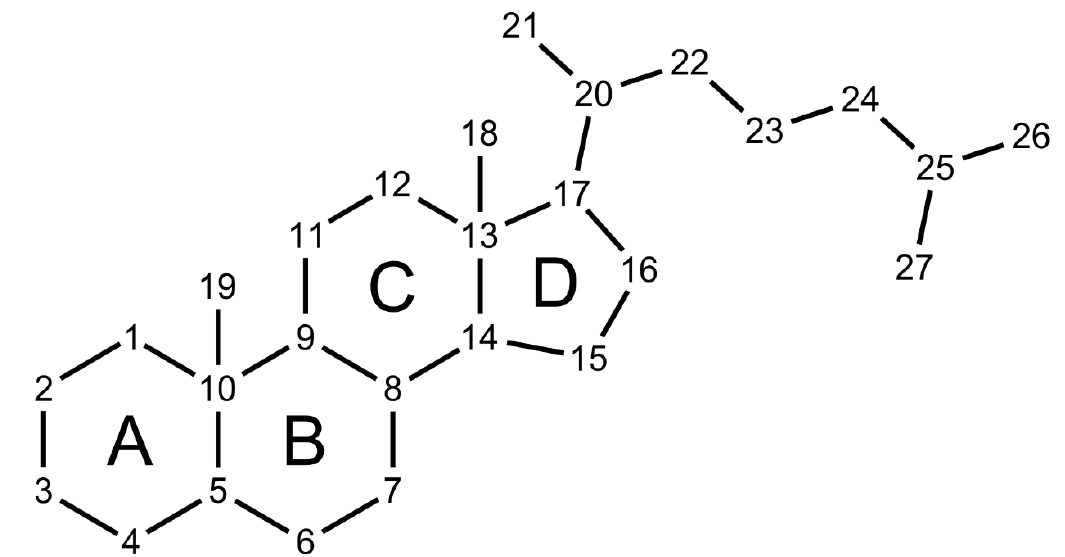
Figure 1. Steroid structure. Steroids have a cyclopentanoperhydrophenanthrene ring structure. Cholesterol, the precursor to human steroid hormones, contains 27 carbons, while the major classes of steroid hormones contain the following: C 24 bile acids, C 19 androgens, C 18 estrogens, and C 21 glucocorticoids, mineralocorticoids, and progestogens.